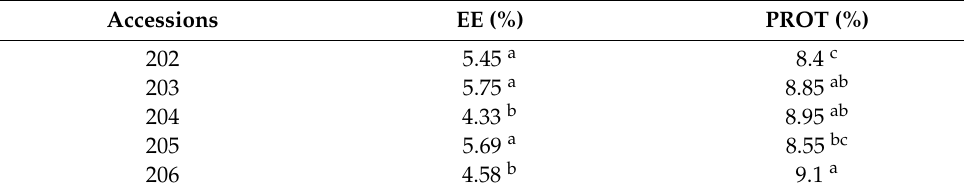
Table 4. Chemical composition of the grain of native corn from the Jalisco Highlands, Mexico.